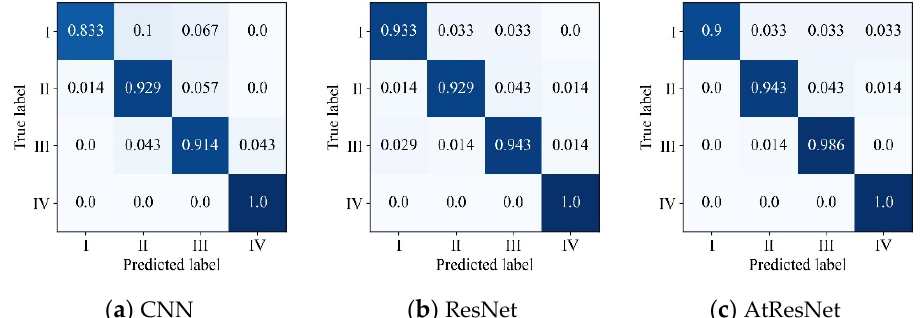
Figure 8. Confusion matrix of tiller number recognition results.